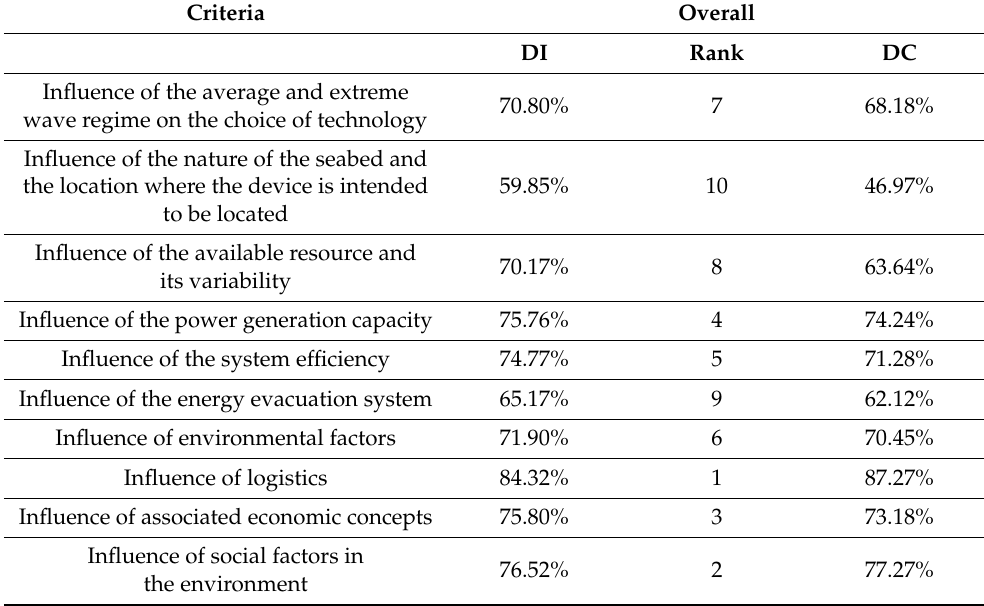
Table 6. Degree of importance (DI) and degree of consensus (DC) for all blocks evaluated.